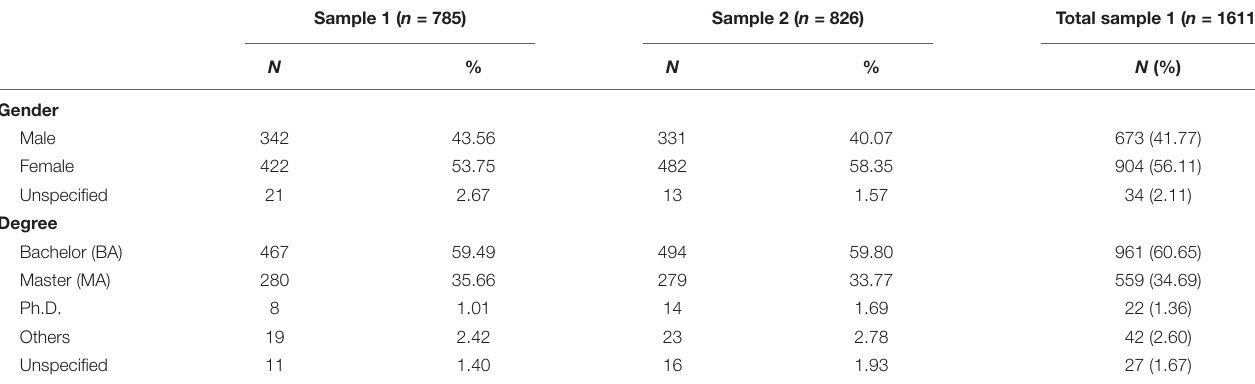
TABLE 1 | Teacher demographic